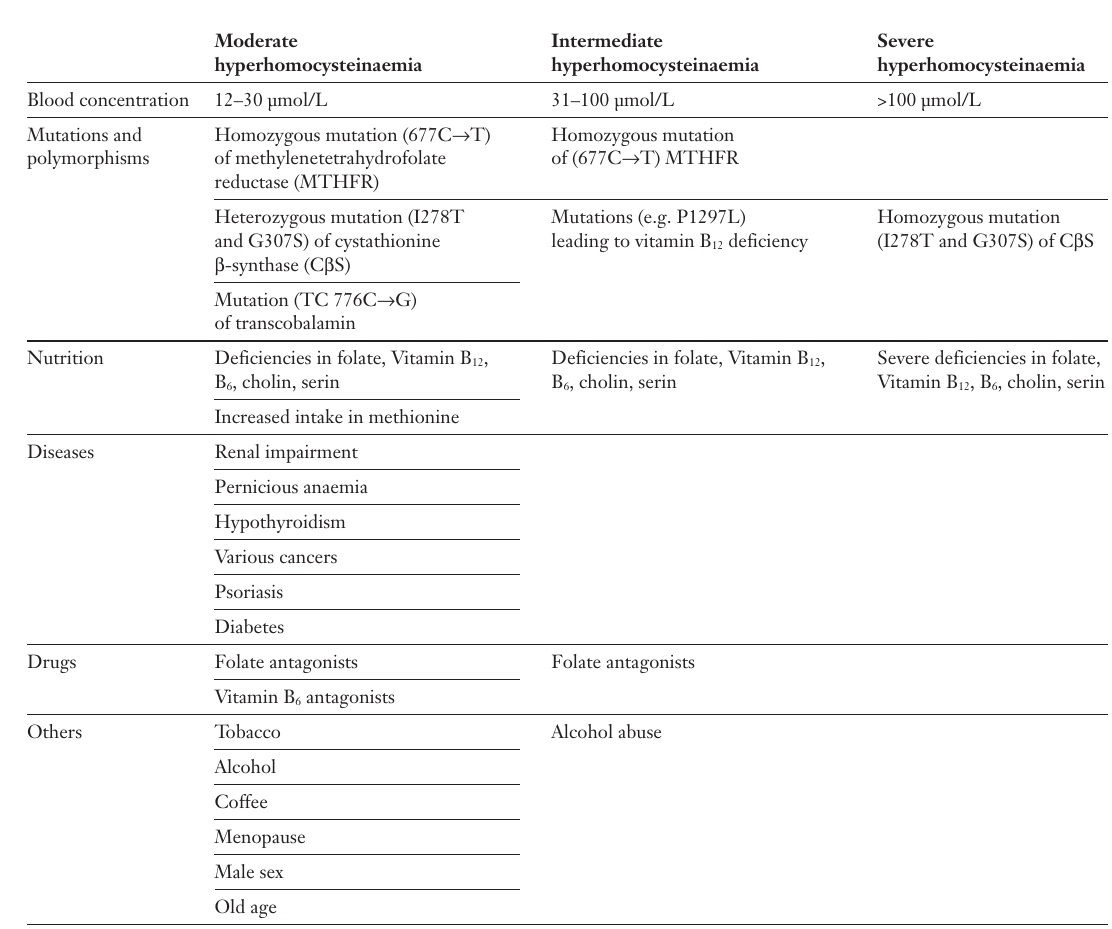
Table 1 Causes of hyperho- mocysteinaemia of different